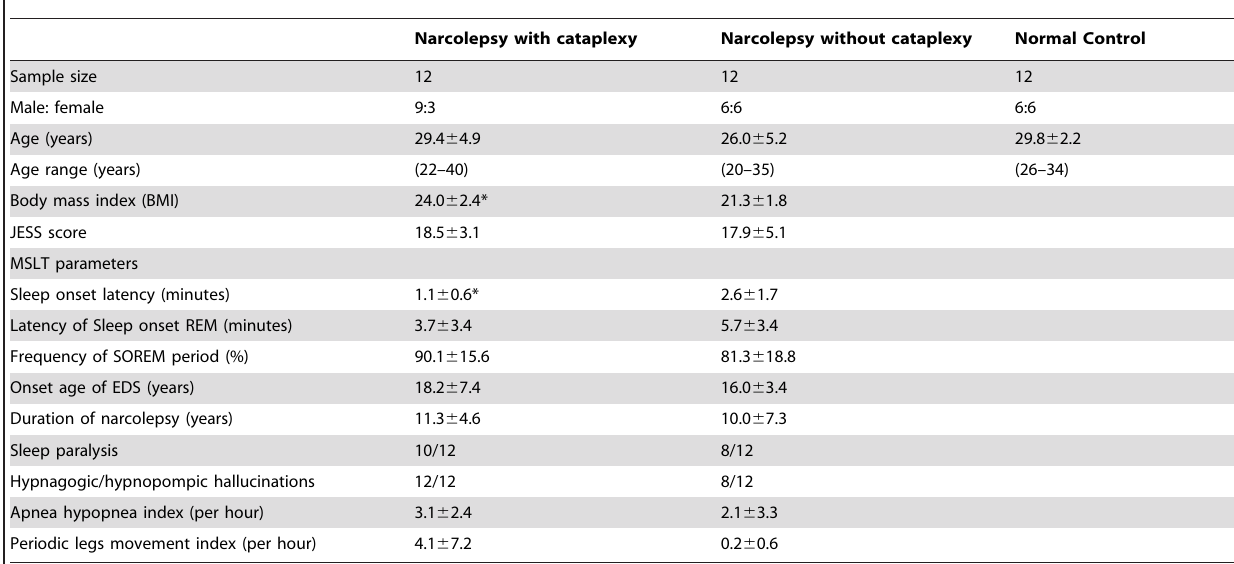
Table 1. Clinical and neurophysiological data of patients having narcolepsy with and without cataplexy.